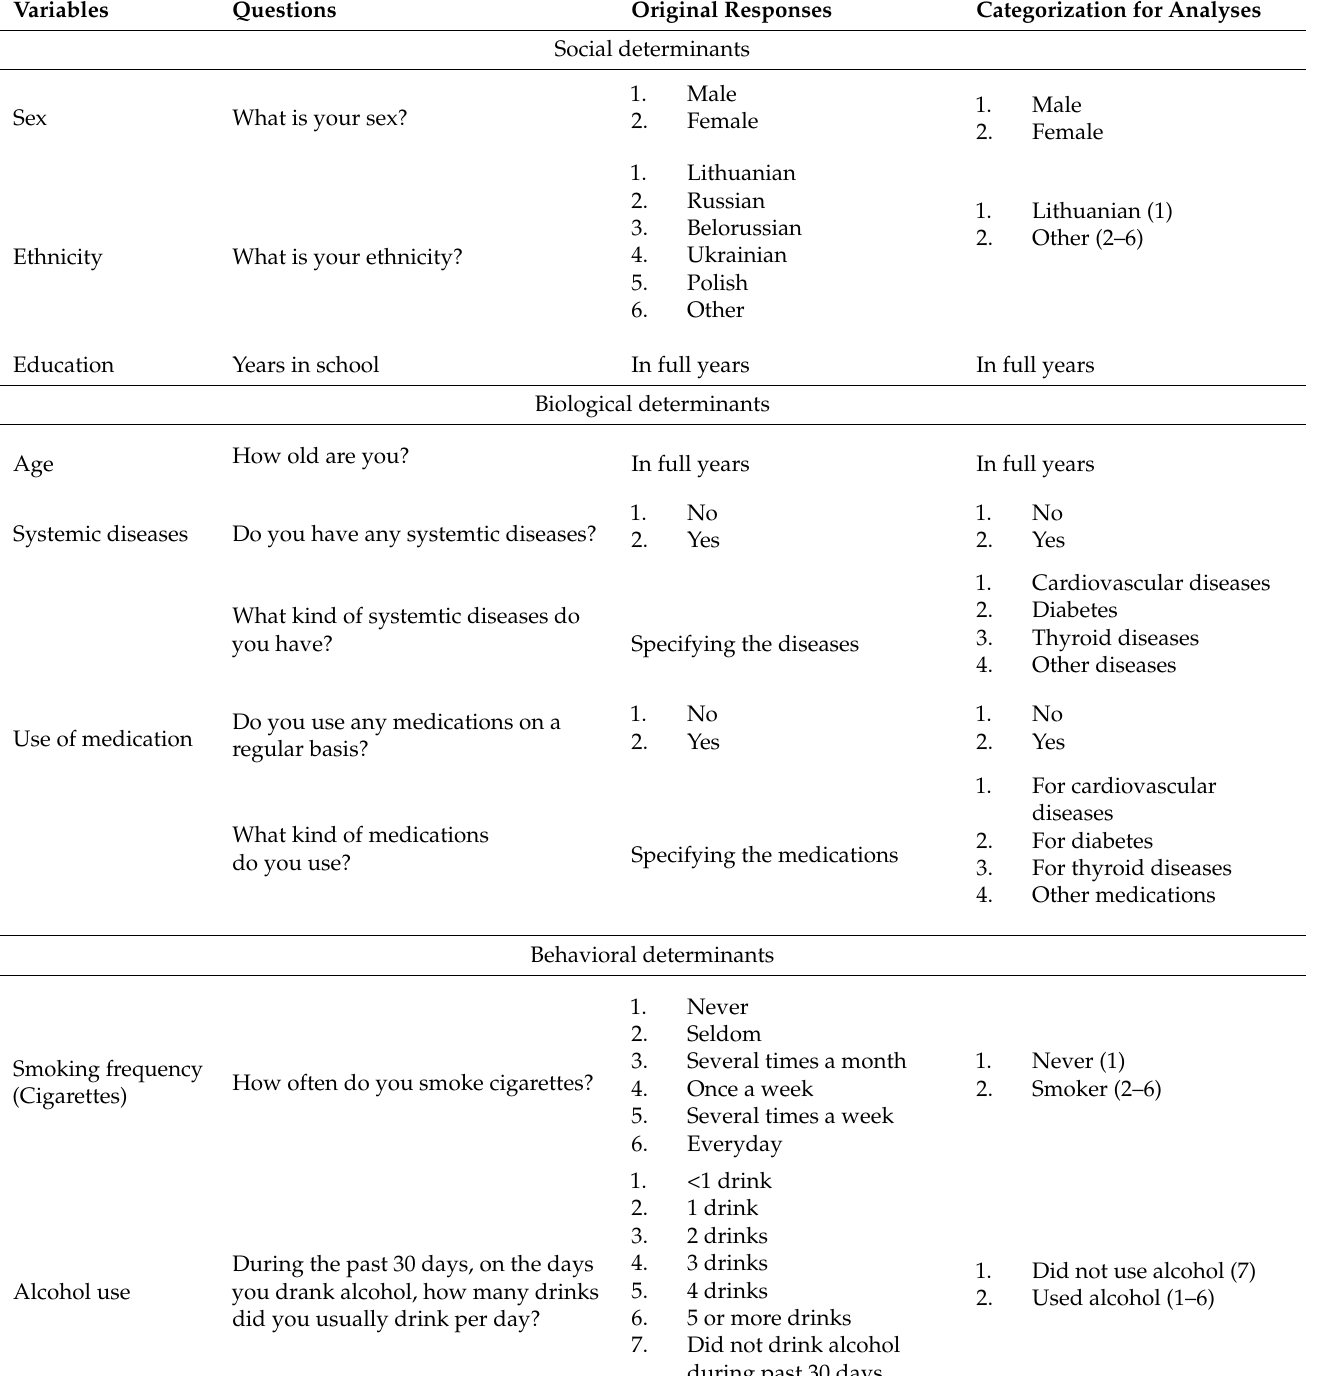
Table 1. Operationalization of study variables and their categorization for statistical